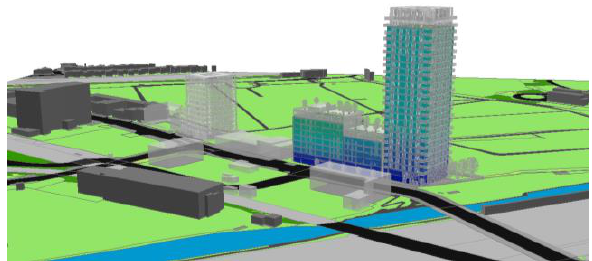
Figure 3 The air quality model viewed from the west side of the development.